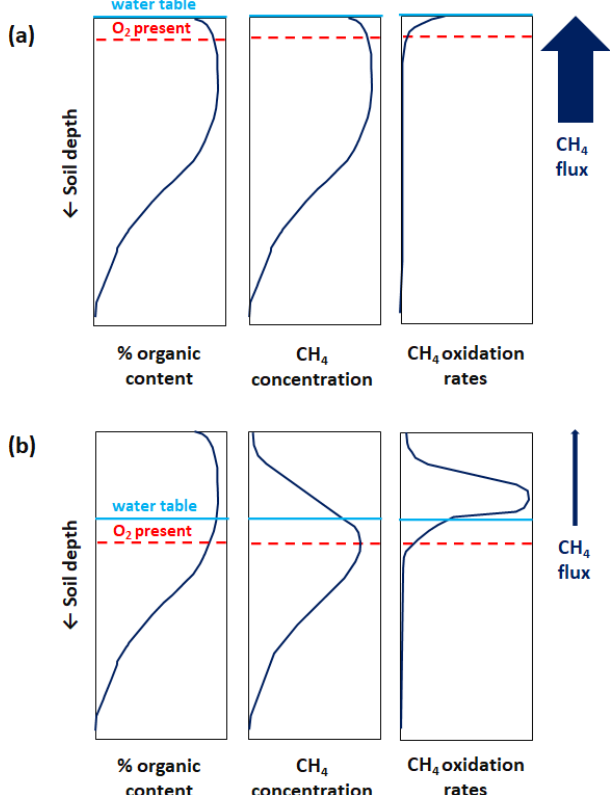
Figure 1. Illustrated vertical profiles of soil organic content, CH 4 concentration, and oxidation rates in a soil column with inundation at the surface (a) and without inundation at the surface (b) . The vertical profiles are based on principles outlined in the literature (Blodau et al., 2004; Whiticar and Faber, 1985). As an illustrative simplification, the soil organic content is assumed to be identical in (a) and (b) . Furthermore, the CH 4 concentration profile is assumed to mirror CH 4 production rates at depth within the soil column (see explanatory text in Sect. 2.4). The blue horizontal line illustrates the water table position, and the dashed red horizontal line illus- trates the oxic–anoxic interface or maximum depth at which O 2 is available in the soil column. The relative magnitude of CH 4 flux in the soil column is shown by the upward arrow to the right, also characterizing the relative magnitude of CH 4 emissions into the at-